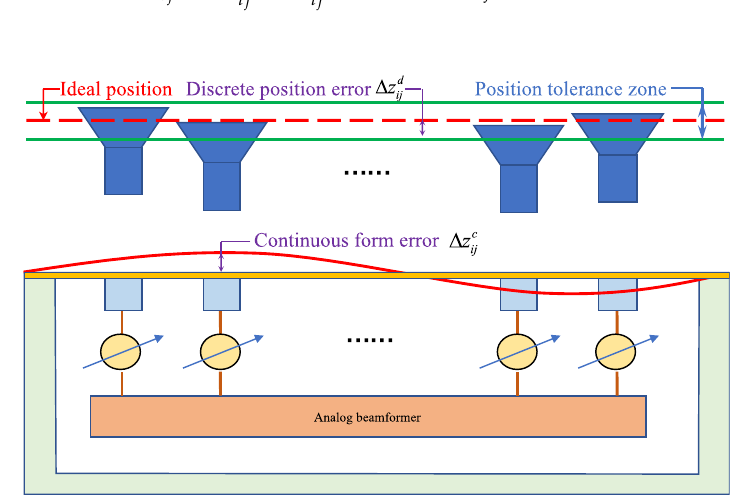
Figure 3. The schematic diagram of hybrid position error of the subarray.